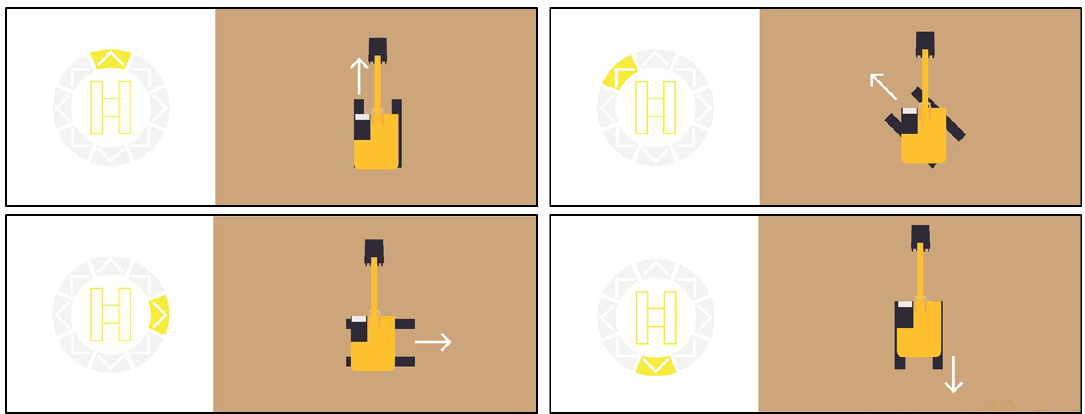
Figure 8. In this concept, the cabin is always facing forward, while the undercarriage can point to eight different directions. Each segment represents one of these directions.